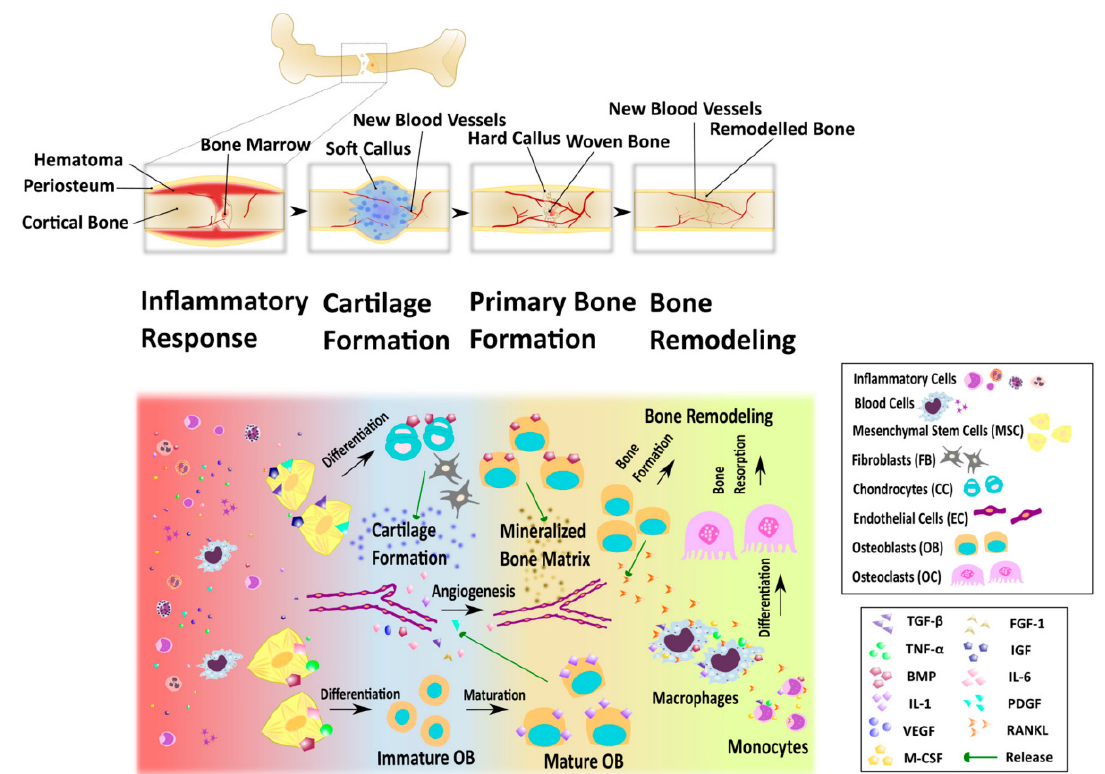
Figure 10. Schematic diagram of the stages of fracture healing. The upper part: the changes of bone tissue in the process of repair; the second part: some cellular aspects of bone repair and the factors involved in the bone repair process. Data reproduced from ref. [113].